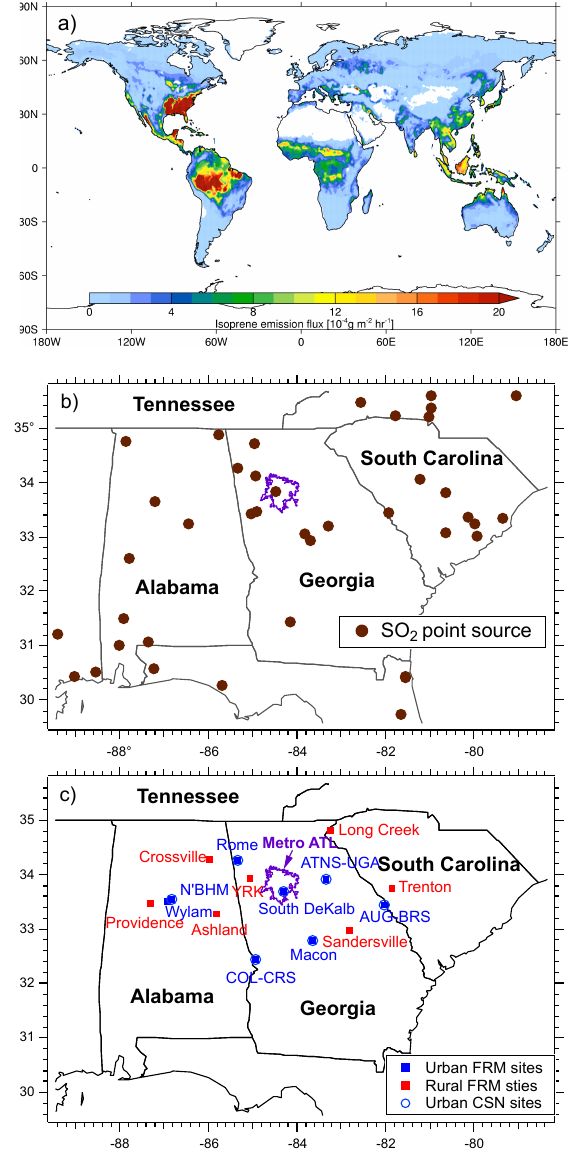
Fig. 1. Maps of (a) MEGAN-ECMWF global annual isoprene emis- sions in 2007, (b) SO 2 point sources based on EPA National Emis- sion Inventory (NEI) 1999, and (c) geographic locations of FRM and co-located CSN sampling